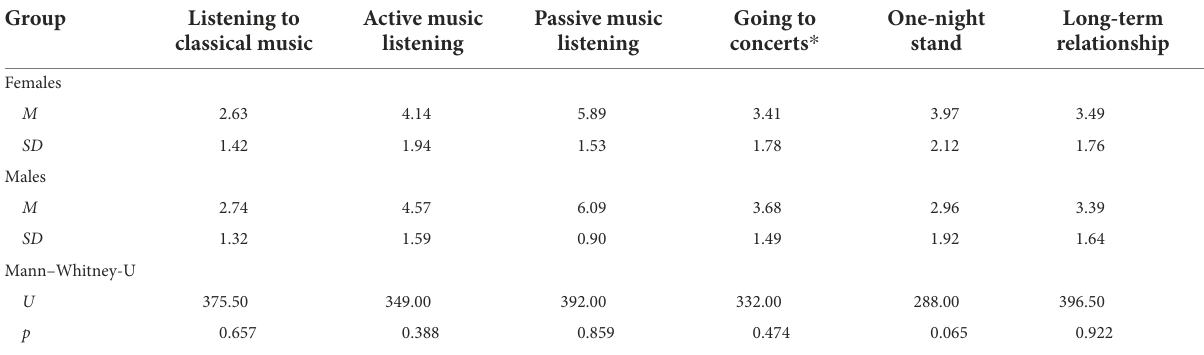
TABLE 2 Participant characteristics II.